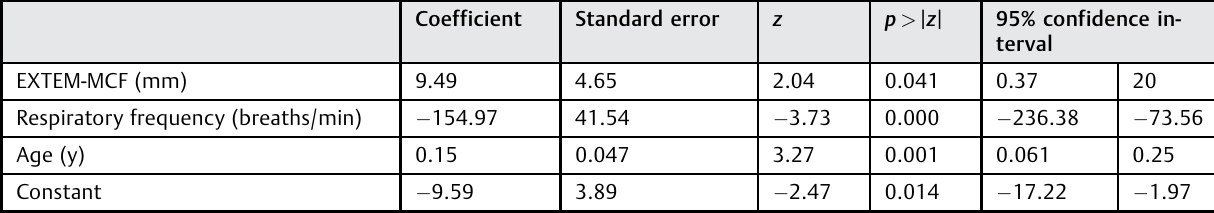
Table 3 Logistic regression for mortality at 30 days